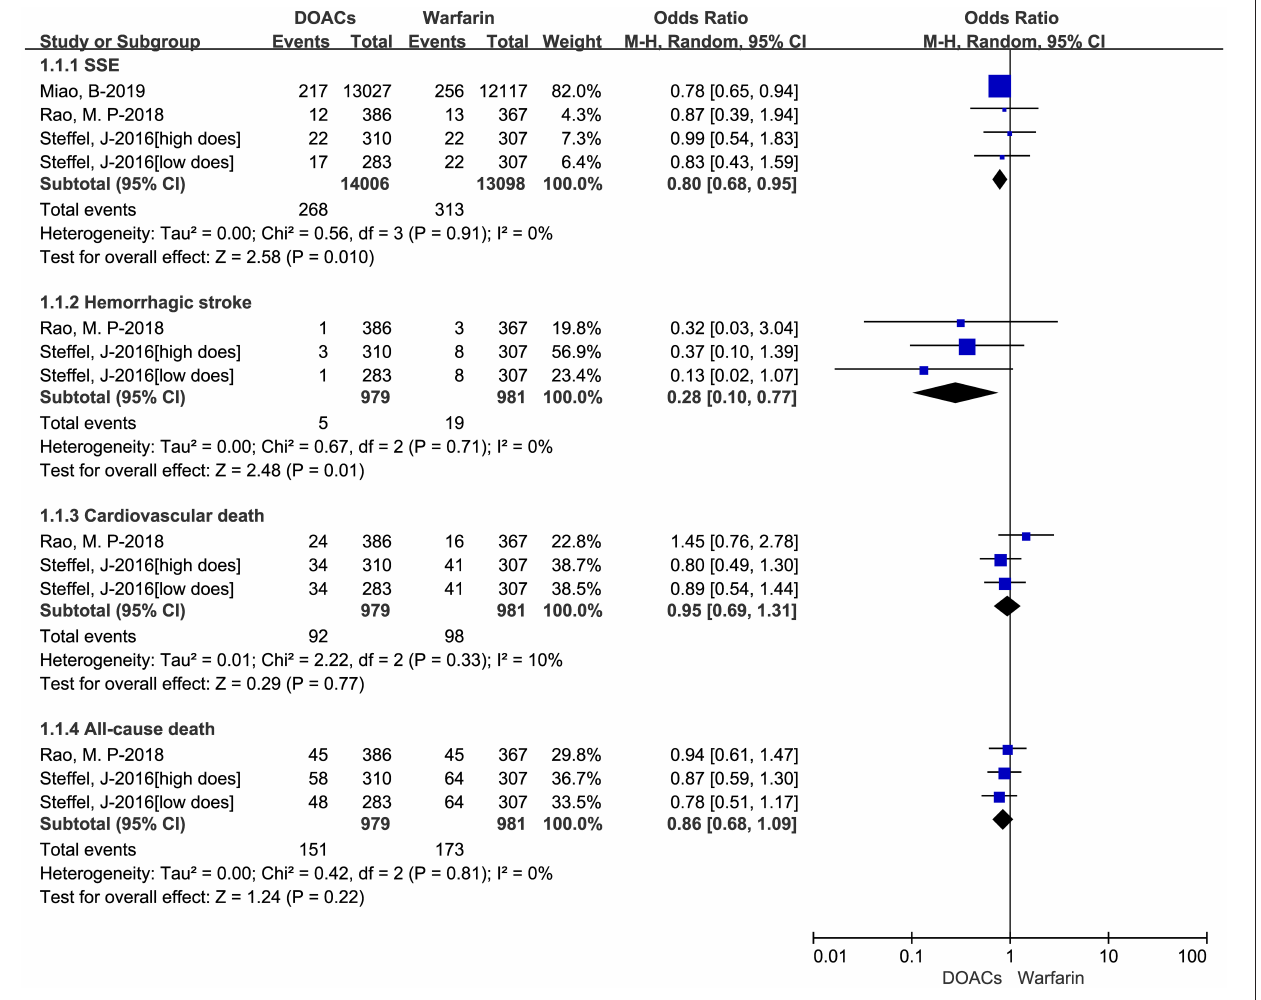
Supplementary Figure 2 . A total of 111 studies were found through electronic searches. Removing the duplicate